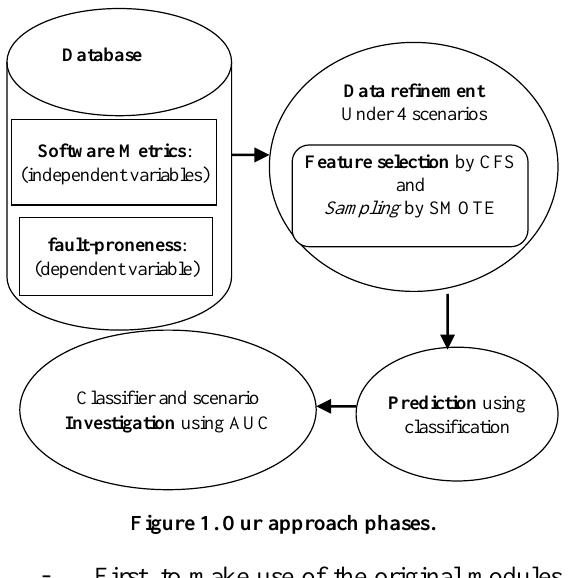
Figure 1. Our approach